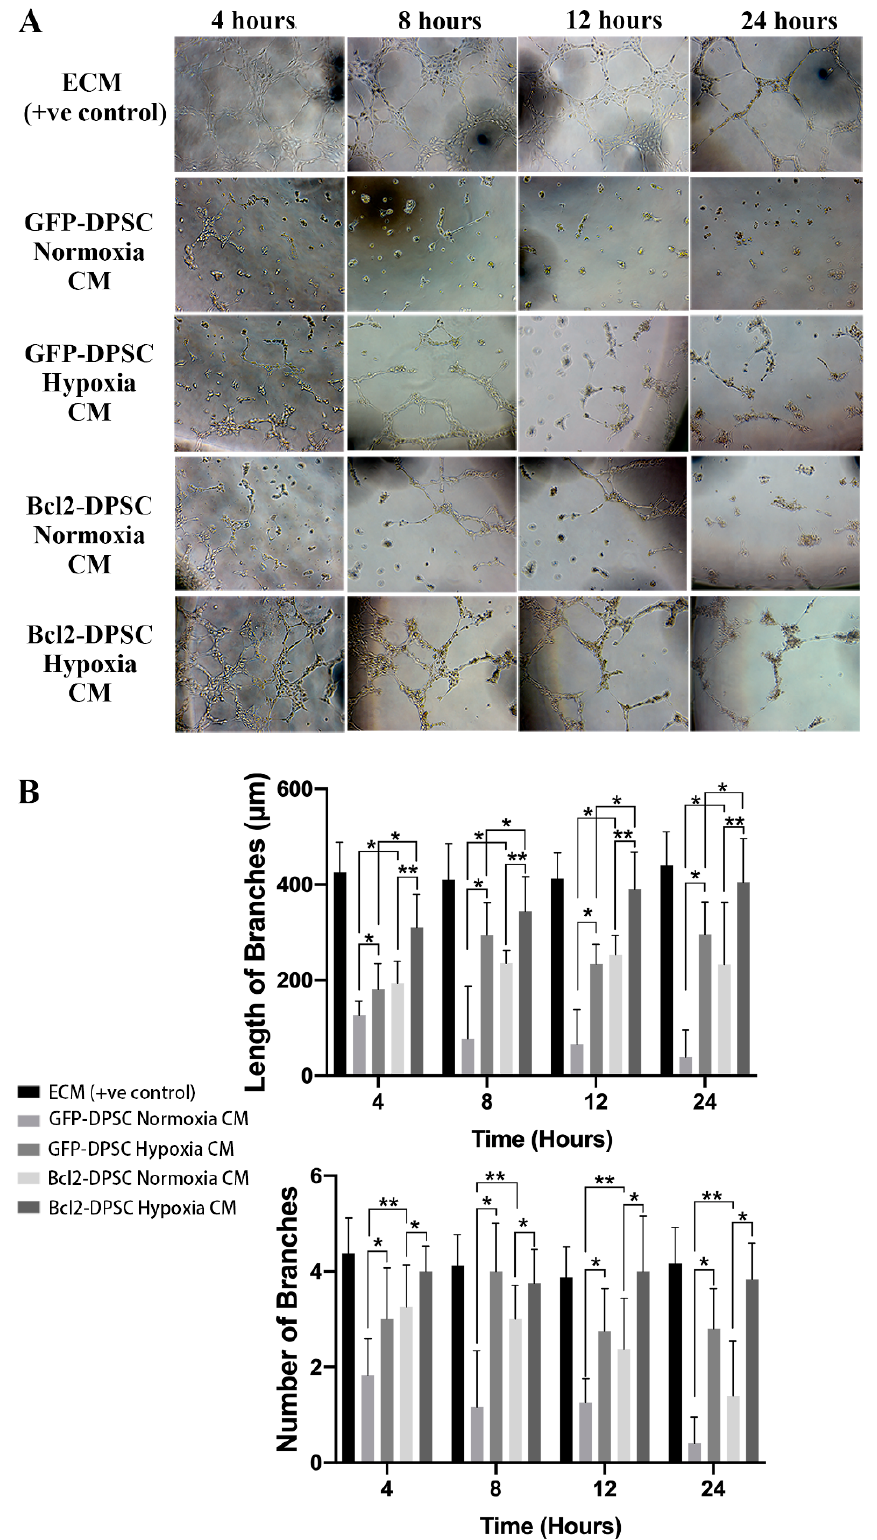
Figure 5. ( A ) Brightfield images of Matrigel tube formation assay. HUVECs cultured in conditioned media (CM) from Bcl-2-DPSCs under hypoxia formed a vascular network similar to that cultured in endothelial cell medium (ECM). ( B ) Quantification of length and number of vascular tubes formed by HUVECs. * p < 0.05, ** p < 0.01, versus the corresponding controls.